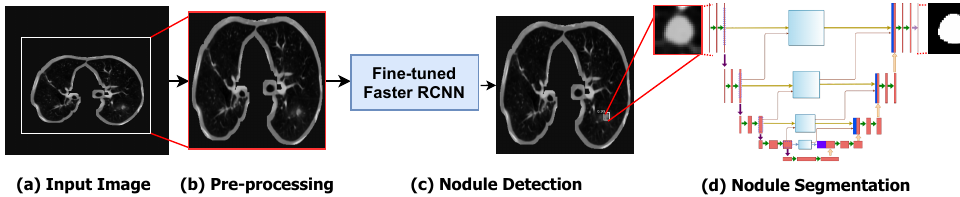
Figure 1. The step-by-step workflow of the proposed method. ( a ) The converted input image is extracted from the original CT slice. ( b ) The pre-processing step for selecting ROI of lung. ( c ) The detection of lung nodules using Optimized Faster R-CNN. ( d ) The segmentation of lung nodules using the proposed AWEU-Net model.